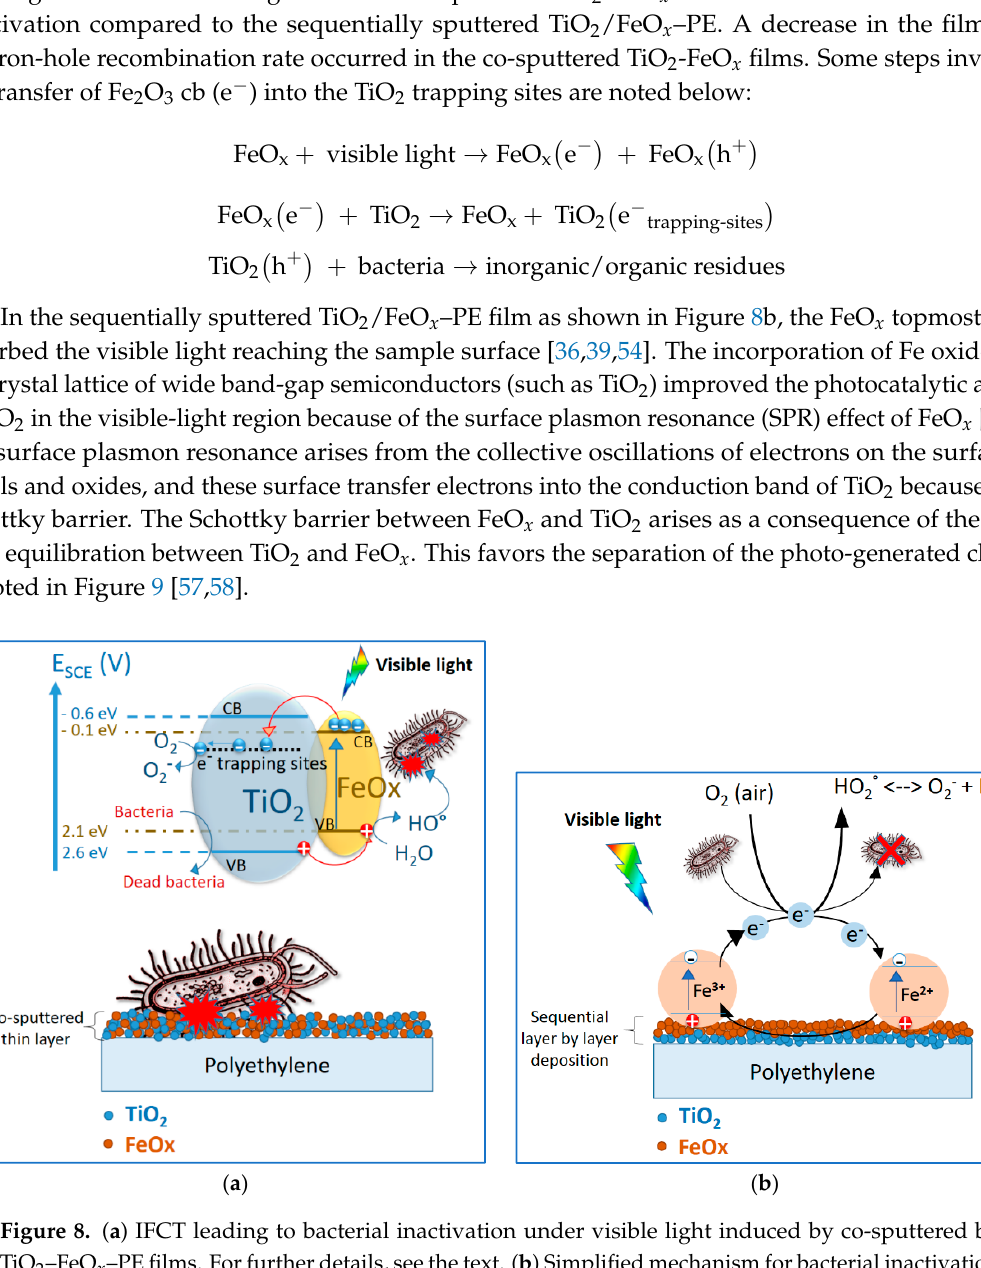
Figure 9. Equilibration of TiO 2 –FeO x nanocomposites with redox couple (bacteria) ( a ) before and ( b ) after irradiation. Figure 10. IFCT at the TiO 2 –FeO x heterojunction under ( a ) solar light irradiation (UV-component) and ( b ) under visible-light irradiation.